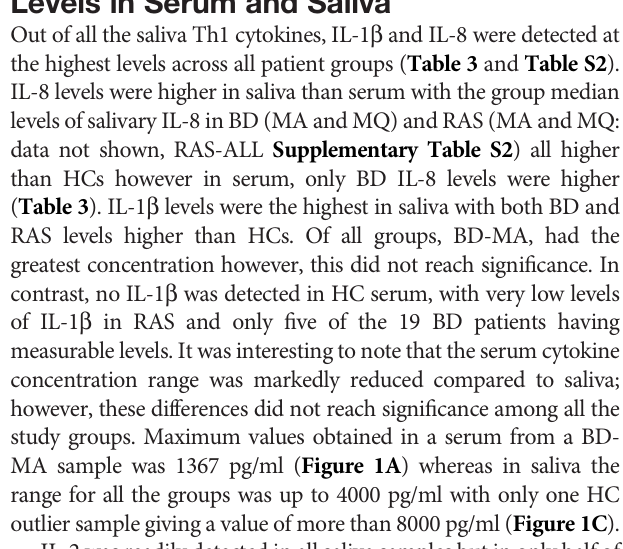
TABLE 1A | Behc ̧ et ’ s Disease Patients demographics for saliva and serum analysis. Demographic and Clinical Features of Behcet ’ s Patients (N=20) Mean Age ±SD,